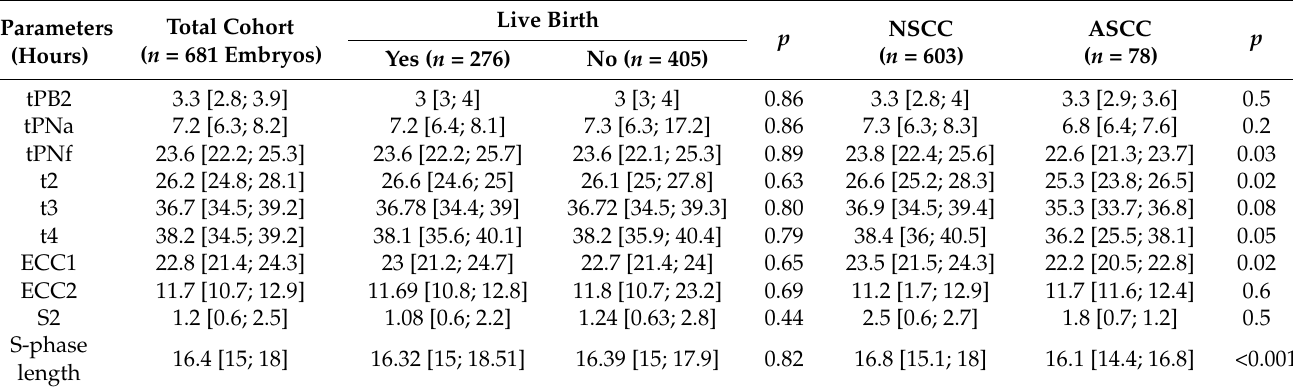
Table 3. Morphokinetic parameters of 681 embryos obtained after ICSI according to the occurrence of live birth and sperm chromatin condensation